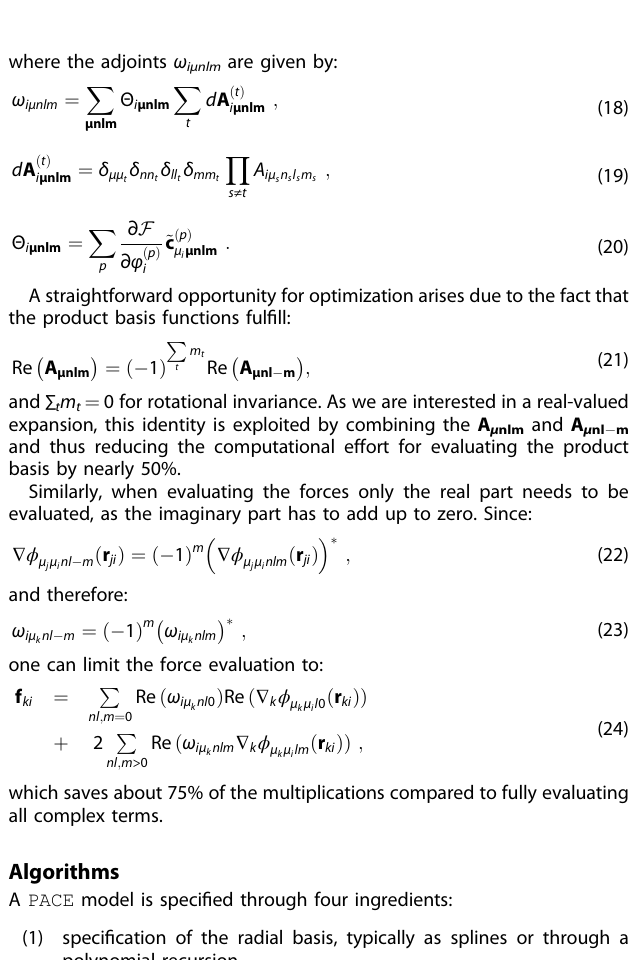
Algorithm 2. Product basis functions A